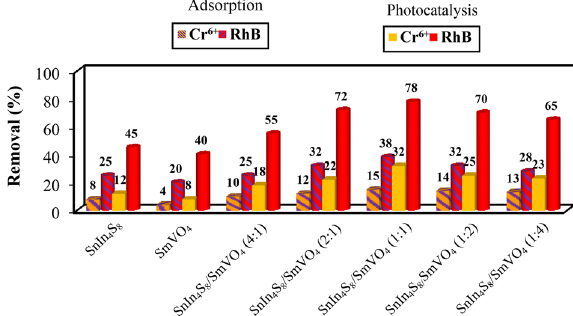
Fig. 5 Comparison of the adsorption and photocatalytic perfor- mance. Effect of the simplex and binary powders on Cr 6 + and